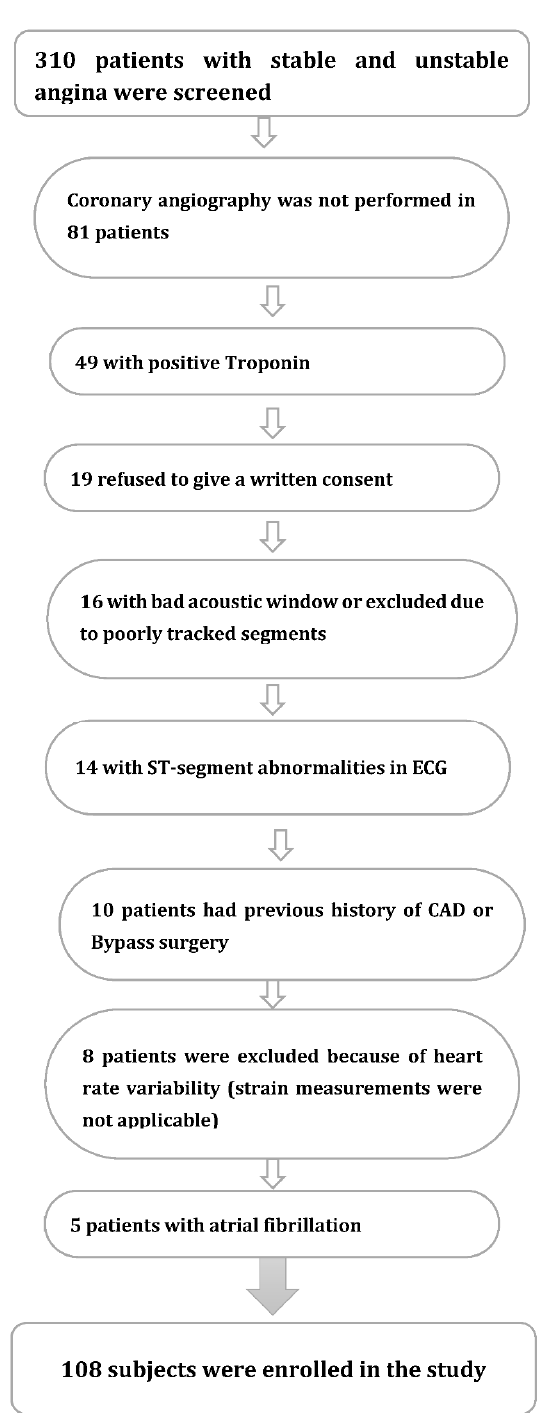
Figure 1. Flow chart of patients enrolled in the study and reasons for exclusion.